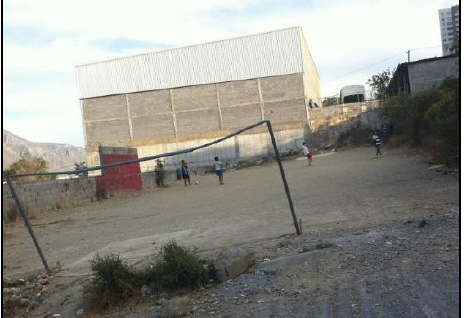
Figure 17. Inhabitants improvising a football court in the non- developed land (Gómez,